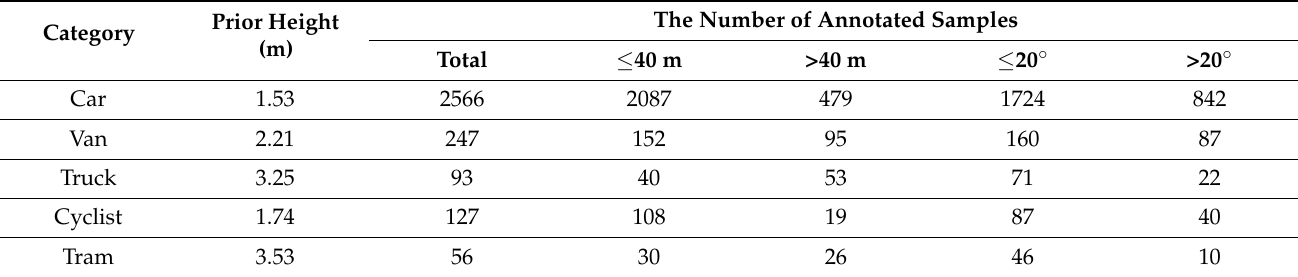
Table 3. The prior height and number of annotated samples of KITTI test set.